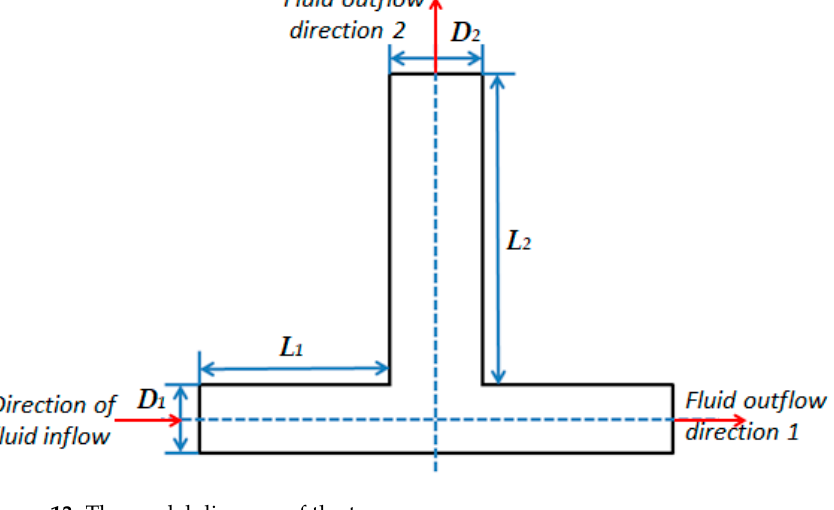
Figure 14. The 3D model diagram of the tee. In Figure 13, D 1 end is the fluid inlet end, D 2 end and D 3 is the fluid outlet end, the direction shown by the arrow is the direction of fluid flow in the pipe and L 1 and L 2 are the pipe lengths of the reducer inlet and outlet pipes, respectively. In order to eliminate the influence of pipe import and export on the study results of the tee erosion, take L 1 = L 2 = 1000 mm. D 1 is the inlet diameter of the tee; D 2 is the outlet diameter of the tee tube in vertical direction; the outlet diameter of outlet 1 is kept constant with D 1 , and the influence of the change of outlet diameter on erosion is studied by changing the outlet diameter D 2 of outlet 2. Similarly, the mesh division of the tee is similar to that of the reducer, and the shape of the mesh division is chosen to be triangular. The number of boundary layers is 10, the incremental index is 1.2 and the maximum mesh width is 6 mm. The mesh division of the tee is shown in Figure 15.